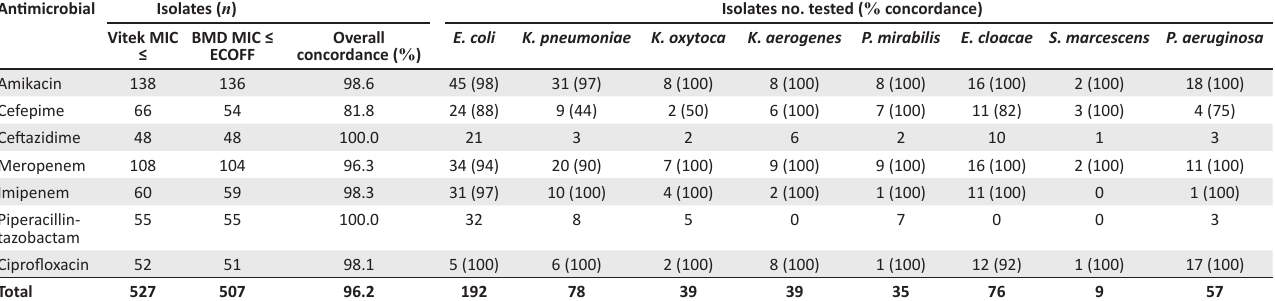
TABLE 1: Overall concordance between Vitek® lowest calling range result and epidemiological cut-off value with stratification of isolates tested per antimicrobial. Antimicrobial Isolates ( n ) Isolates no. tested ( % concordance) Vitek MIC